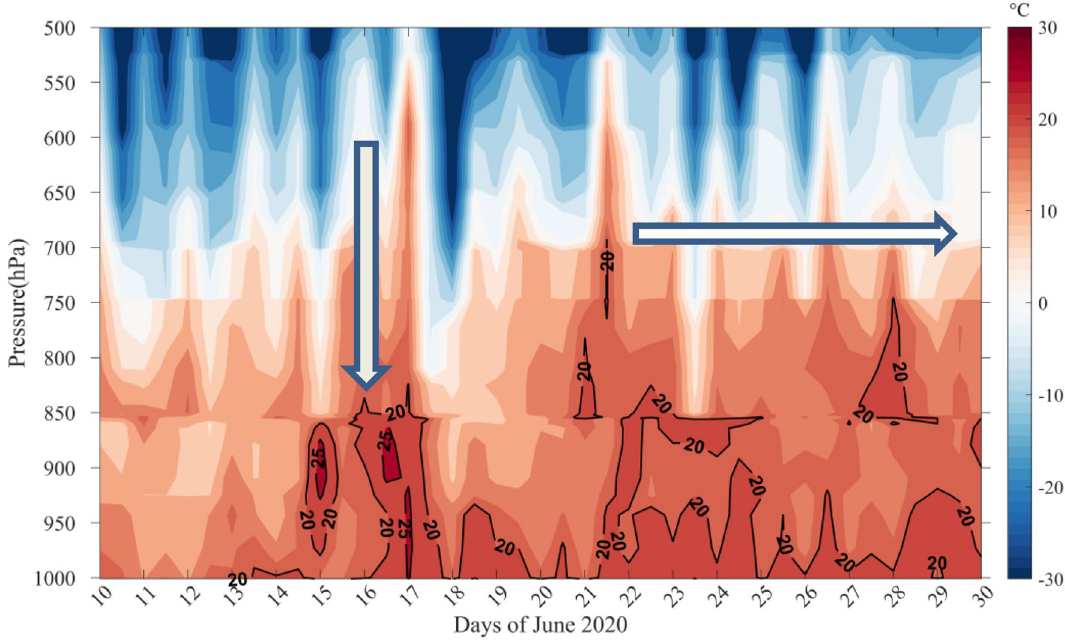
Figure 8. The time-height plot of temperature at Guimar-Tenerife (Station latitude: 28.47 °N Station longitudes: − 16.38 °W). The map was generated using MATLAB 2015b, www. mathw orks.